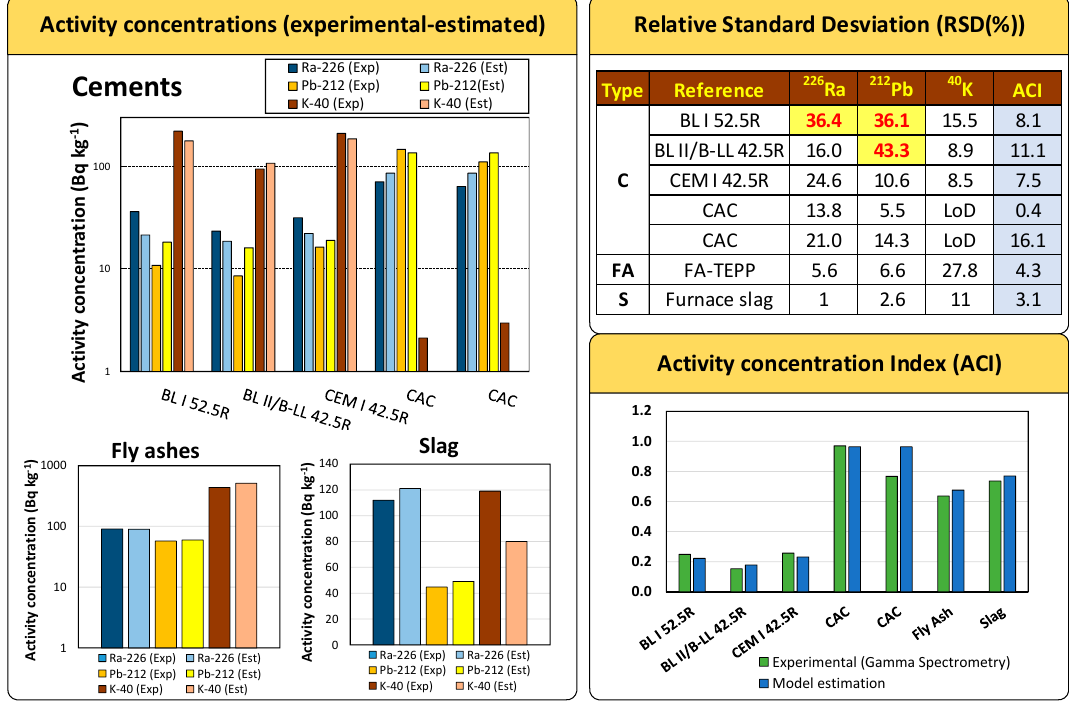
Figure 9. Validation of activity concentrations for 226 Ra, 212 Pb, and 40 K, and ACI experimentally determined by gamma spectrometry and those estimated by the proposed models. The validation criterion for satisfactory results was an RSD(%) value of less than or equal to 30%. Eighty-nine percent of the concentrations met the acceptance criterion. The 40 K was also accepted for the 2 samples with an activity concentration value below the limit of detection (LoD). The RSD(%) values obtained for the ACIs were all satisfactory at less than 16.1%.